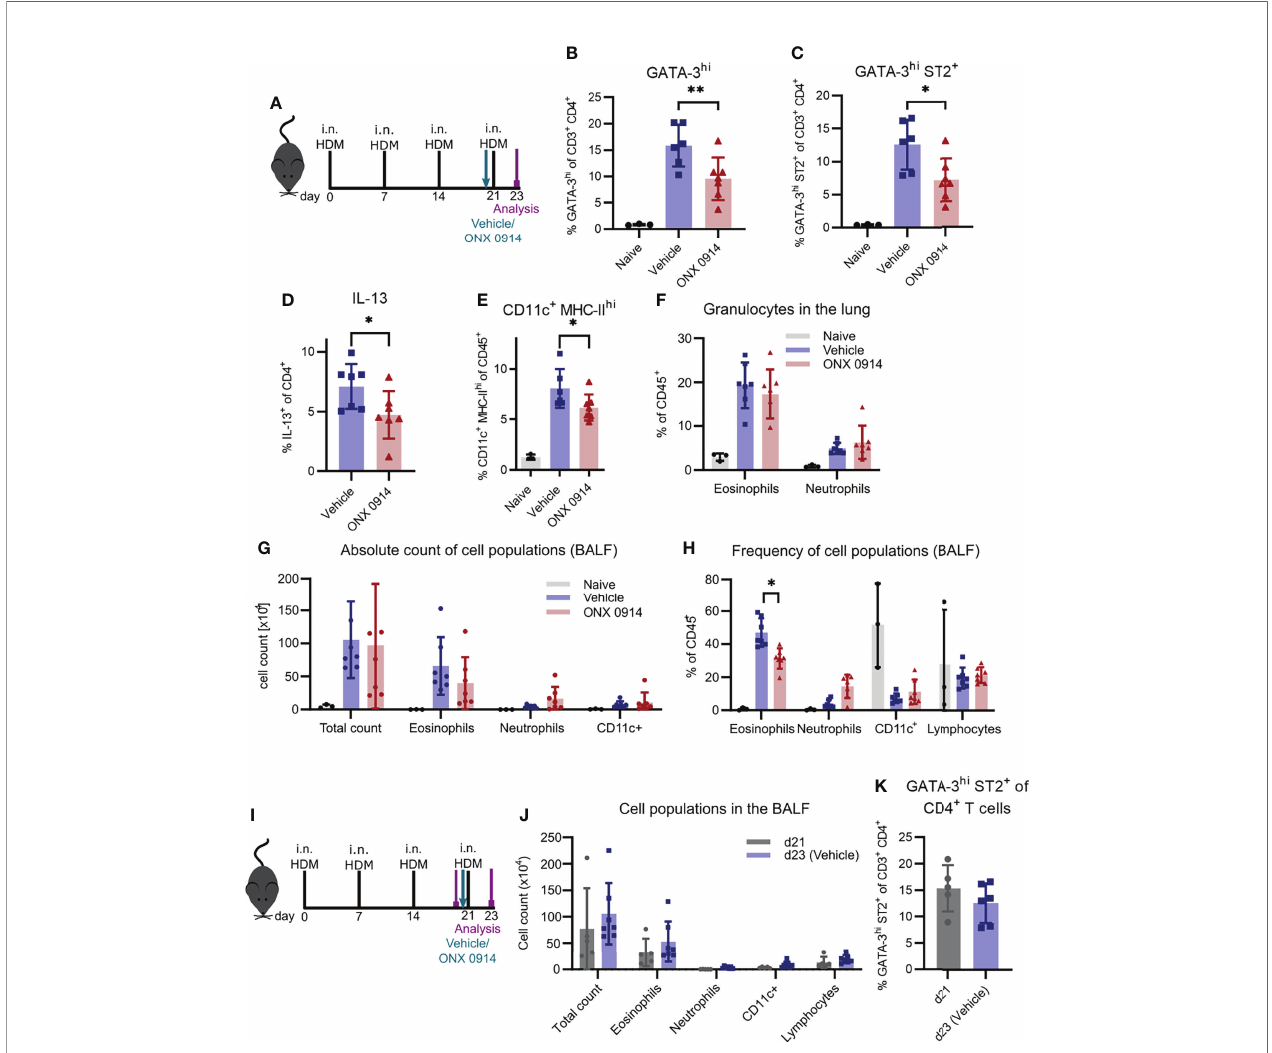
FIGURE 5 | ONX 0914 reduces the Th2 response in house dust mite-induced airway in fl ammation. (A-H ) GATIR mice received intranasal applications of 50 µg house dust mite (HDM) extract on day 0, 7, 14 and 21. One hour before the last immunization, mice were treated with 10 mg/kg ONX 0914 or vehicle subcutaneously. In fl ammatory in fi ltration was analyzed by fl ow cytometry on day 23. Naïve mice served as controls. (A) Schematic setup of experiments (B-H) . Frequency of GATA-3 hi (B) , GATA-3 hi ST2 + (C) and IL-13 + T cells (D) in the lung. Frequencies of (E) CD11c + MHC-II hi cells as well as (F) granulocytes in the lung. (G) Absolute cell counts and (H) relative frequencies of cell populations in the BALF, identi fi ed as eosinophils (CD45 + CD11c - CD11b + Ly6G - Siglec-F - ), neutrophils (CD45 + CD11c - CD11b + Ly6G + ; left), CD11c + and lymphocytes (CD45 + CD11b - SSC-A low ). (I-K) Mice of day 23 (d23 (Vehicle)) were immunized and treated as described above. For analysis of the in fl ammation on day 21 (d21), mice received only three immunizations on day 0, 7 and 14 and were analyzed without treatment and the last immunization. (I) Experimental setup for experiments (J, K) . (J) In fi ltration of myeloid cells in the BALF and (K) frequency of GATA-3 hi ST2 + Th2 cells in the lung on day 21 and 23. Data is shown as mean ± SD (naïve: n=3, vehicle/ONX 0914: n=6-7, d21: n=5). *p <0.05 and **p < 0.01. For better visibility, only the results for the comparison vehicle vs. ONX 0914 are indicated. Groups d21 and d23 were not signi fi cantly